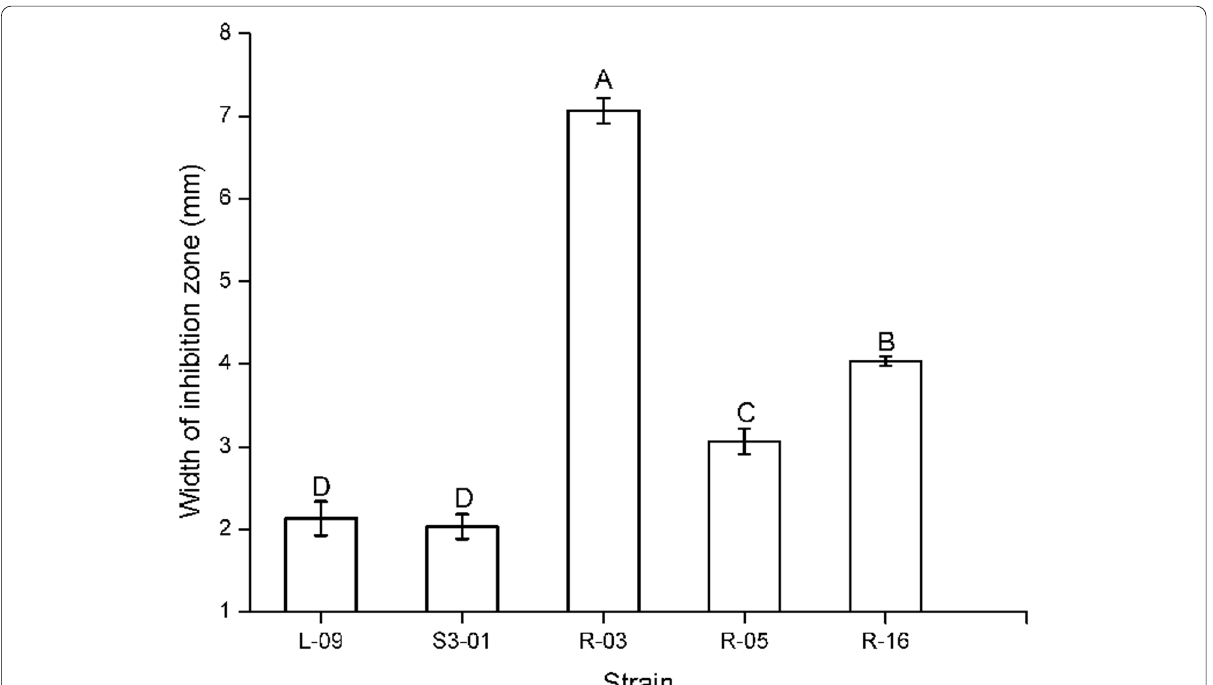
Fig. 3 Width of inhibition zone of five strains against Rhizoctonia cerealis (Kruskal-Wallis test: H SD; different letters indicates significant differences ( α ±